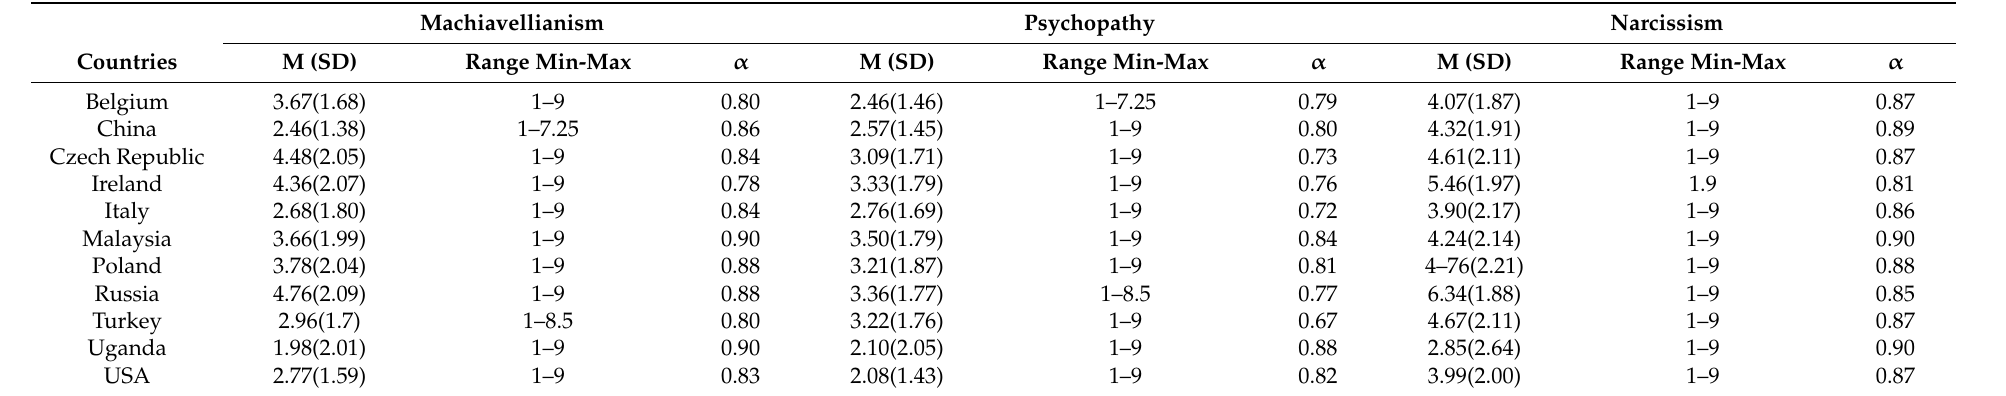
Table 3. Descriptive statistics of dark triad traits by